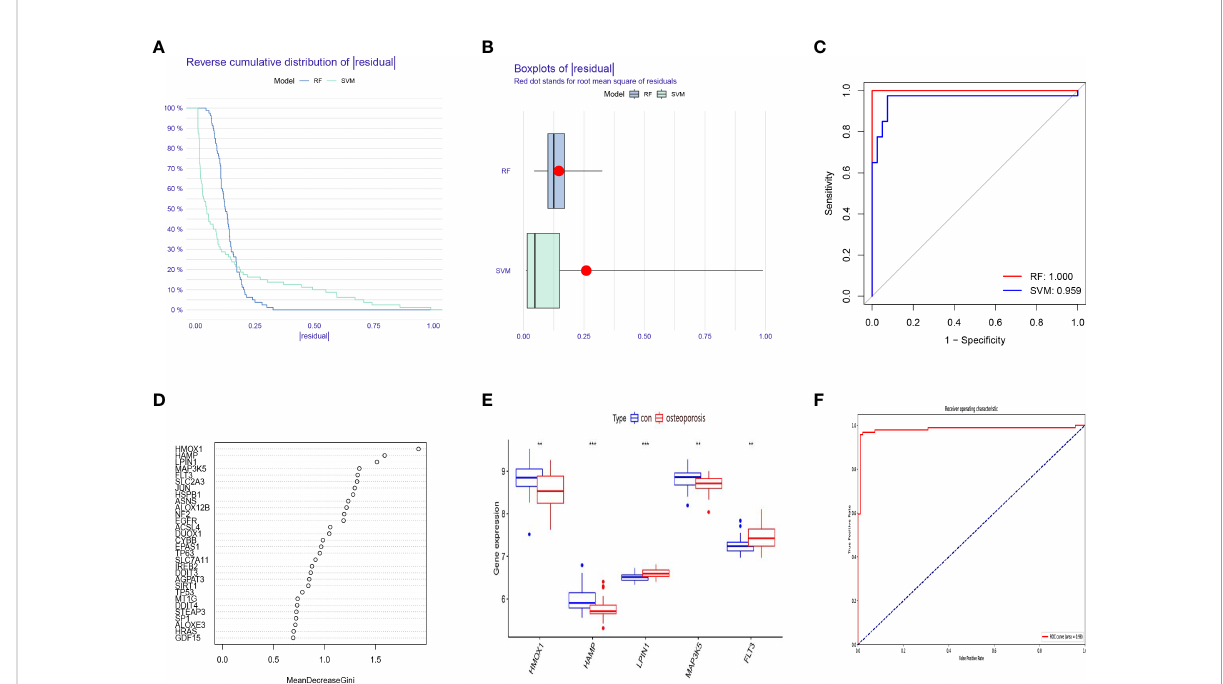
FIGURE 2 Construction and validation of a diagnostic ferroptosis-associated gene signature. (A) Cumulative distribution of |residual| in RF model and SVM model. (B) Boxplots of |residual| in RF model and SVM model. (C) ROC curve and AUC value of RF model and SVM model. (D) The relative importance of explanatory variables ranked by the RF model. (E) The comparison of these fi ve genes between OP and normal patients. (F) The ROC result of our proposed signature in validation dataset. **P < 0.01; ***P < 0.001.